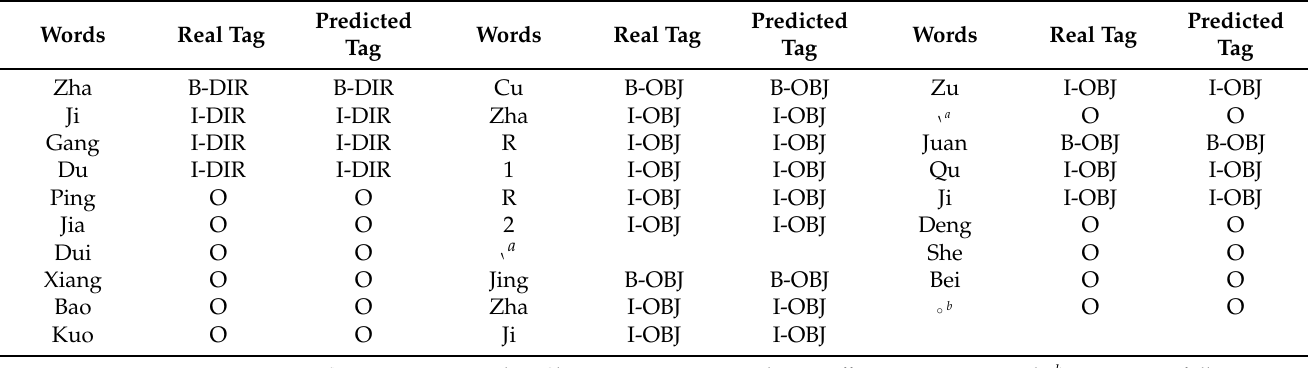
Table 5. Example of recognition results.